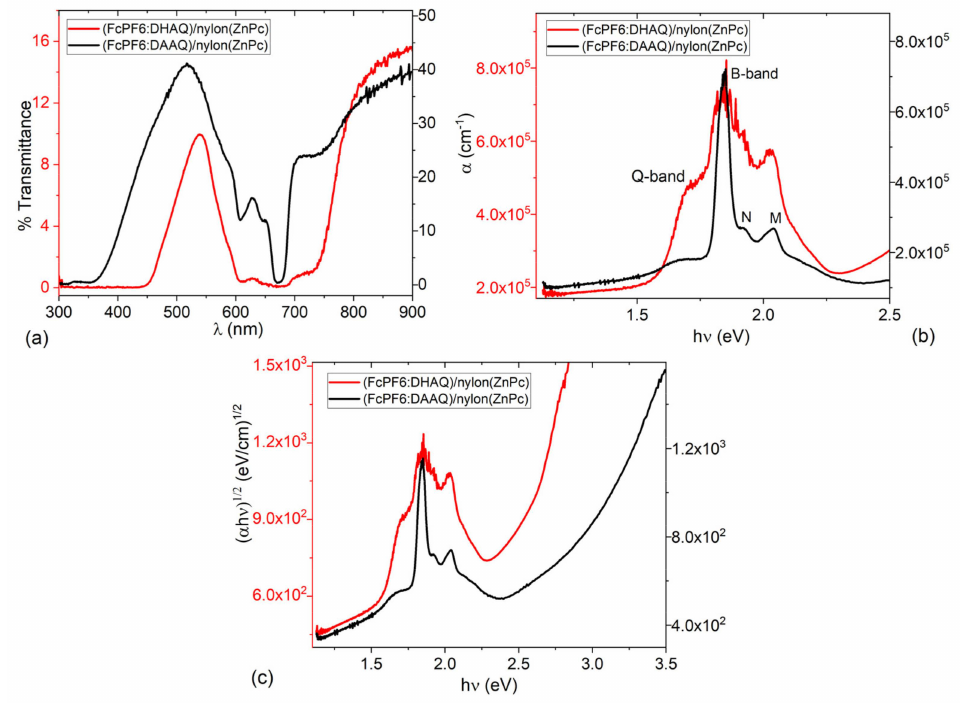
Figure 4. ( a ) Transmittance spectra, ( b ) spectral behavior of absorption coefficient, and ( c ) variation of ( α h ν ) 1/2 with h ν of the organic heterostructures.